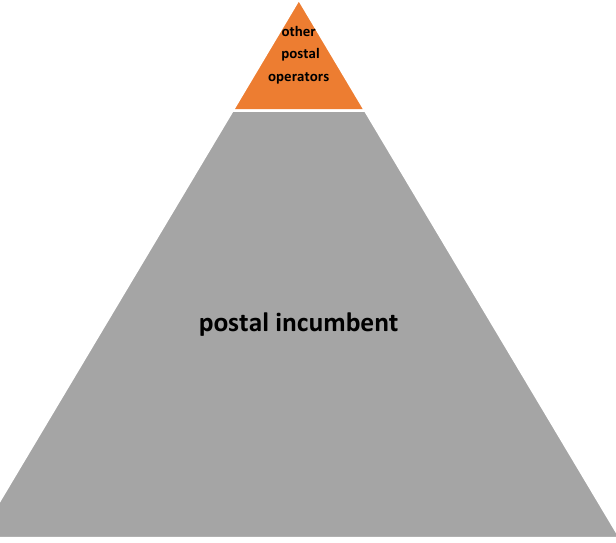
Figure 2. Model strengthening the postal services market. Source: Authors’ own elaboration.